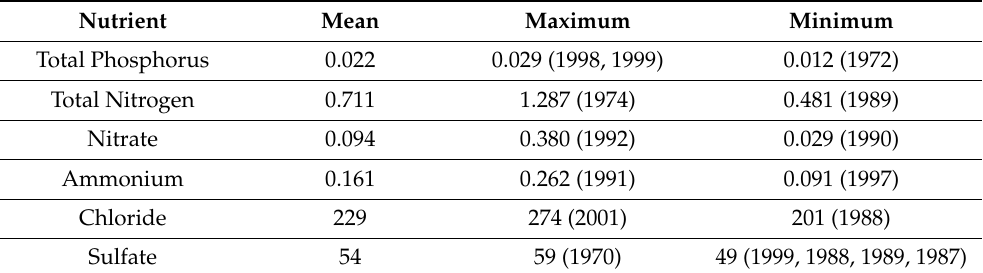
Table 2. Multi-annual (1969–2001) averages (all sampling stations, all sampling dates, and discrete depths), maximum and minimum values of nutrient (total phosphorus, total nitrogen, chloride, sulfate, nitrate, ammonium) concentrations (ppm) in the pelagic waters of Lake Kinneret. The maximum and minimum annual value and respective year are